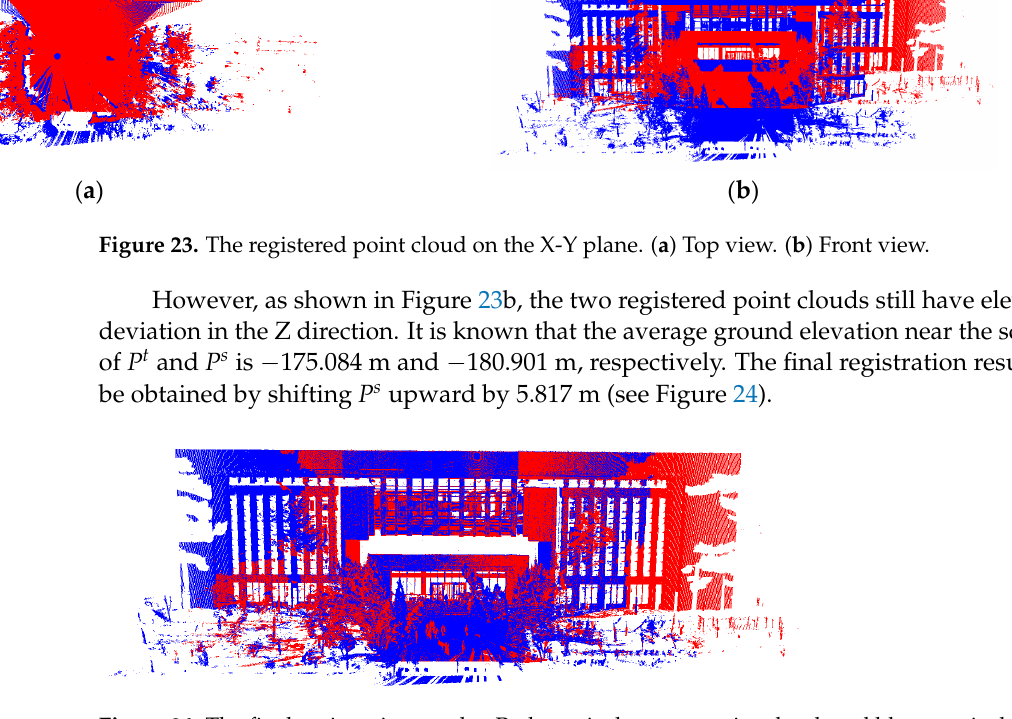
Table 5. The coordinate deviations of 15 homonymous points after registration.